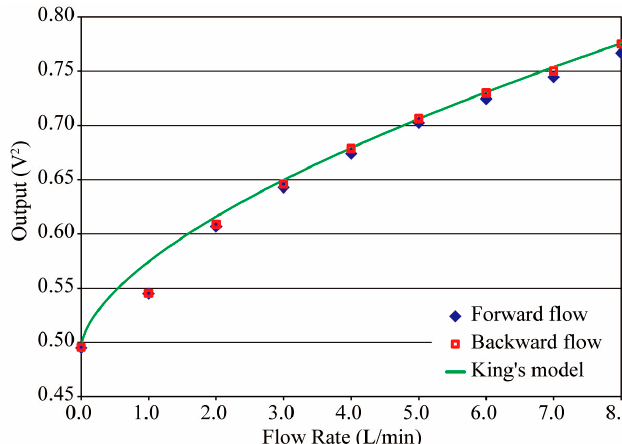
Figure 4. Relationship between flow rate and sensor output.